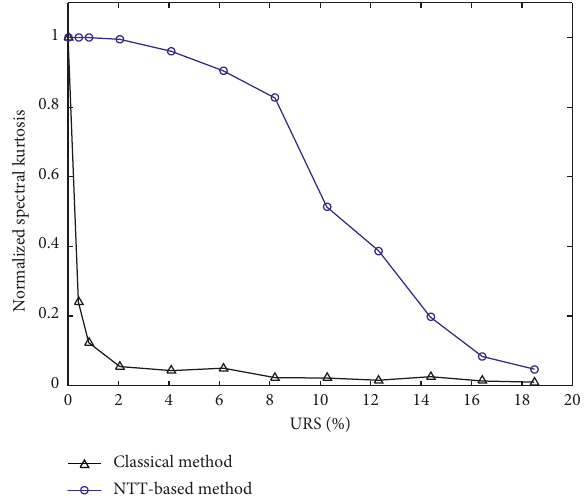
Figure 14: Normalized spectral kurtosis of nonuniformly reconstructed signals under different URS.